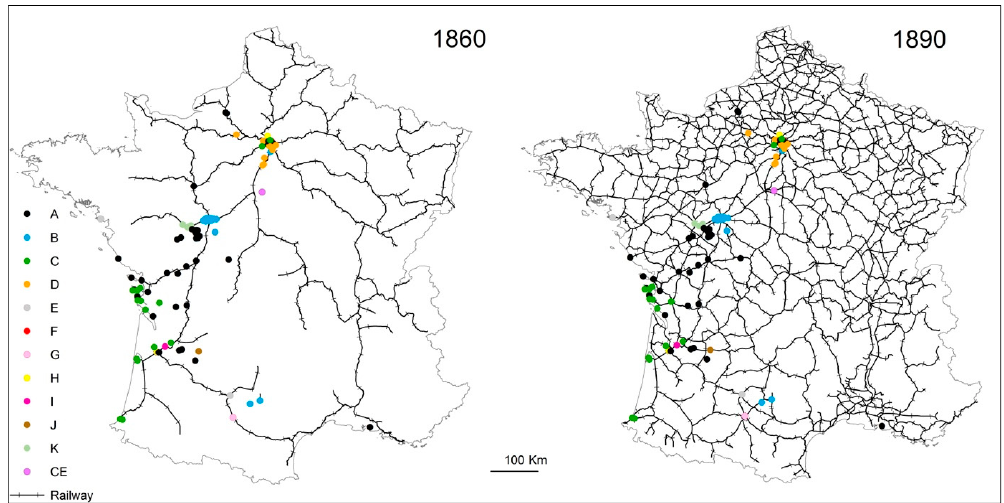
Figure 4. Development of the French railway network over time. The maps show the state of the network in the 1860s and 1890s and the haplotypes (colored letters and dots) at each Reticulitermes flavipes sampling location (free access mapping sources: SNCF Réseau, https://data.sncf.com and EuroGeographic, https://eurogeographics.org/products-and-services/open-data). It may have been fully or nearly concomitant with the arrival of R. flavipes in France, which